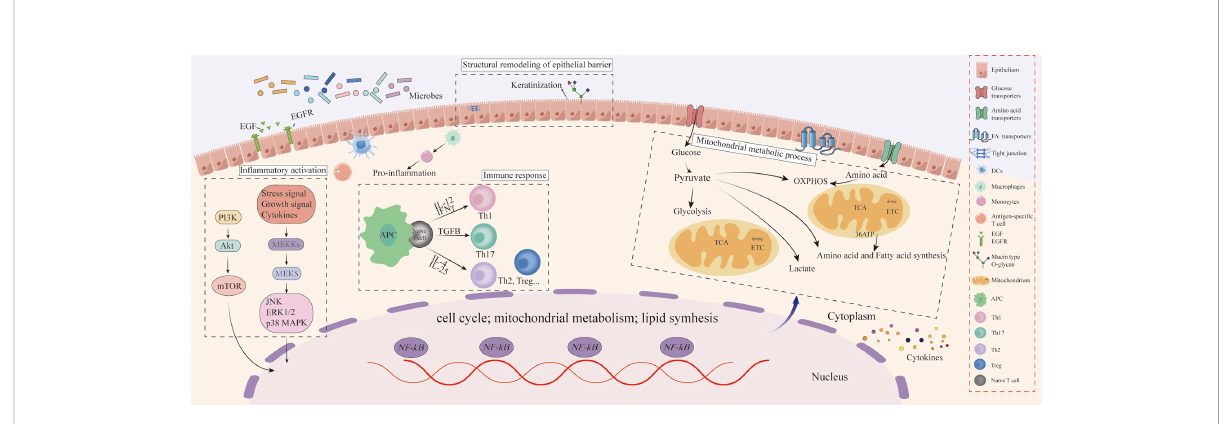
FIGURE 5 Schematic diagram of oral epithelial barrier resistance to microbial